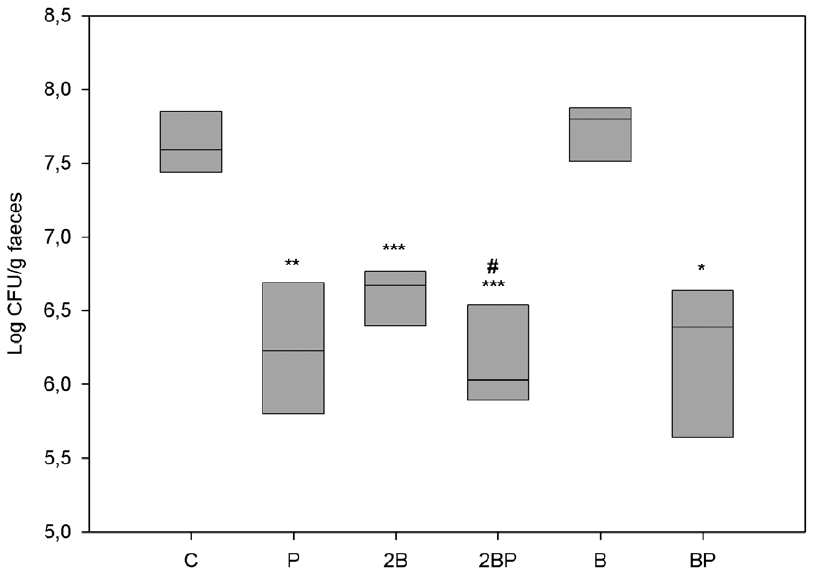
Figure 11. Faecal load of Enterobacteriaceae . Viable count of Enterobacteriaceae (log CFU/g faecal sample) *P , 0.05, **P , 0.01, *** P # 0.001 compared to group C. By the addition of probiotics: group C vs group P **P , 0.01; group 2B vs group 2BP # P # 0.05; B group vs BP group *P , 0.05.